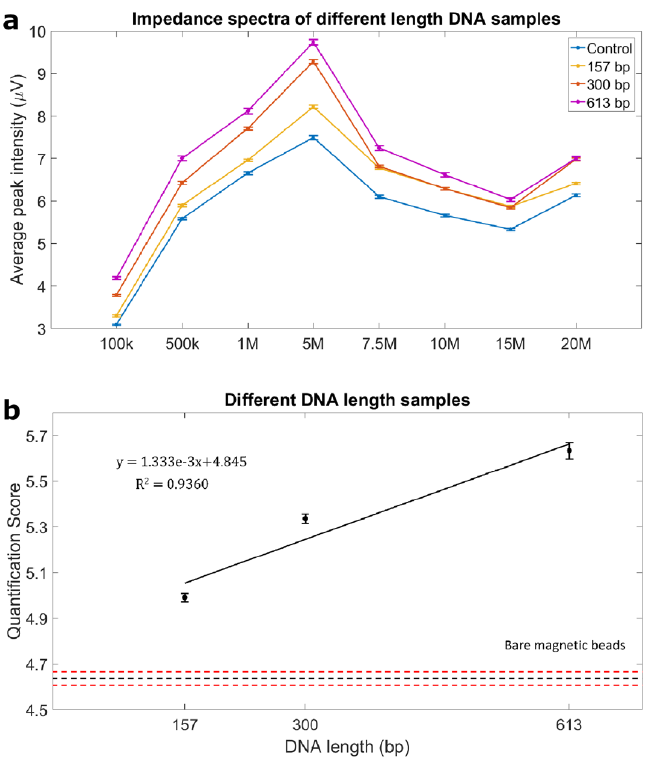
Figure 4. Effect of different DNA lengths of the same concentration on impedance response. Samples with different DNA lengths (ds 157 bp, ds 300 bp and ds 613 bp) but the same concentration (Table 1) were analyzed in comparison to bare paramagnetic beads (M280). ( a ) Impedance spectra for beads attached with different DNA length increased as frequency increased from 100 kHz to 5 MHz and then decreased as frequency increased to 15 MHz. ( b ) The quantification score of different length DNA beads showed a linear correlation between quantification score and DNA length attached to the beads. Error bars represent standard error of mean. Horizontal black and red dotted lines represent the average quantification score of the negative control samples and negative control ± standard error,